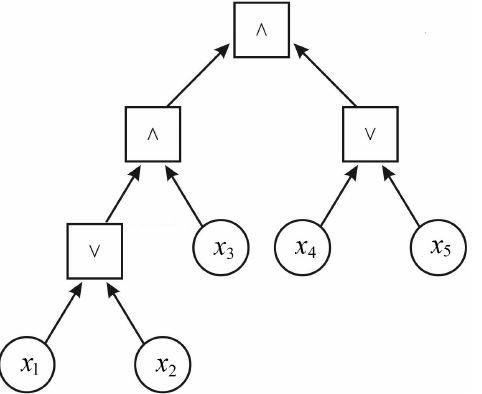
Figure 1. Representation of a logical function A ( x 1 ,..., x n ) in the form of a directed